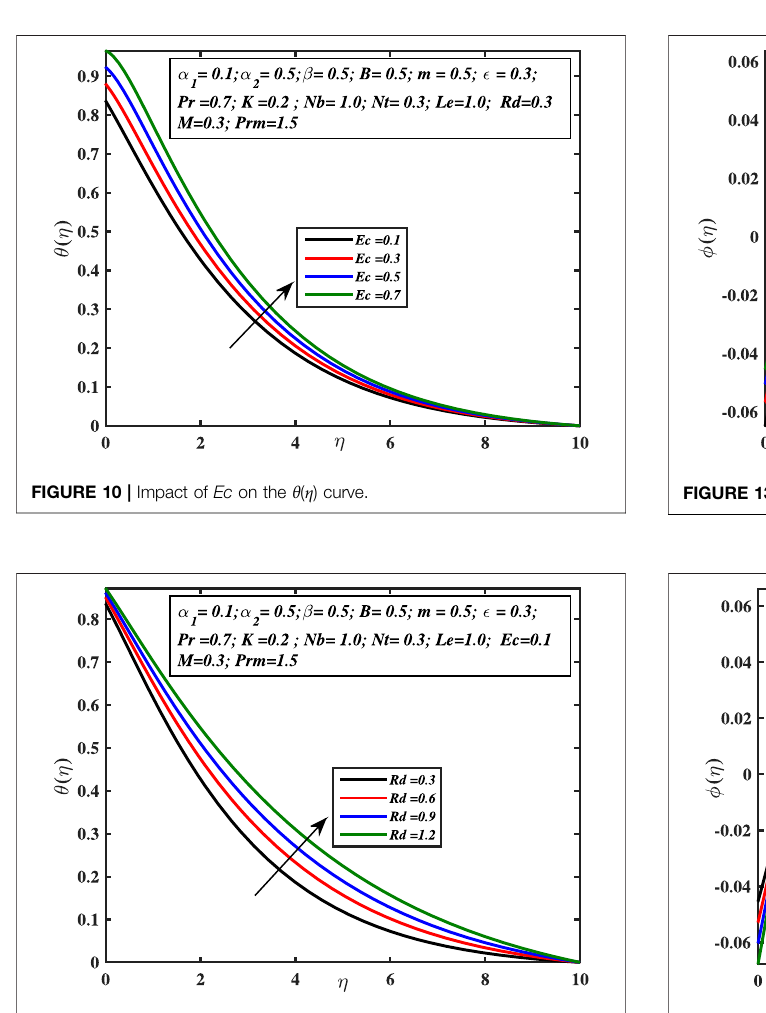
FIGURE 14 | Effect of Nt on the ϕ ( η ) pro fi